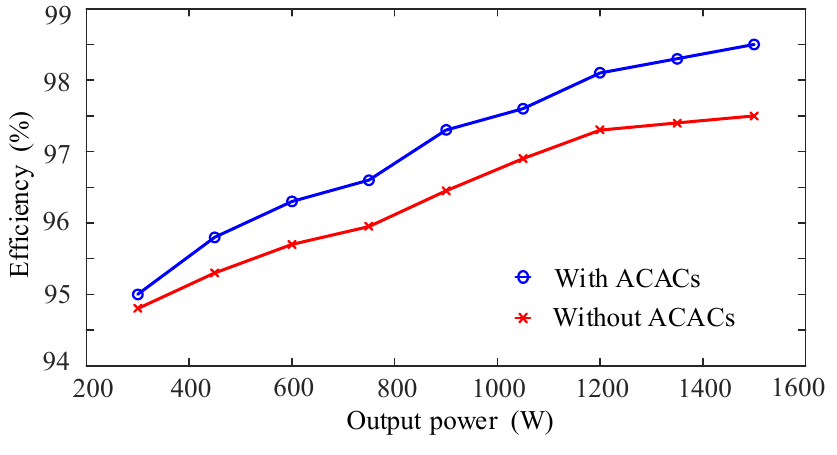
Figure 10. The efficiency of the ITLDC.